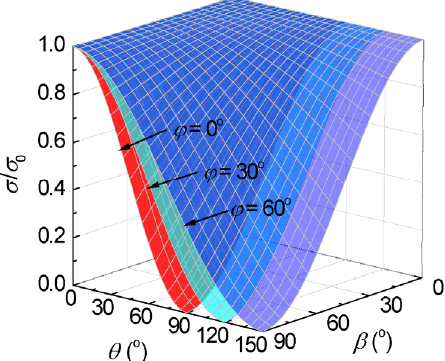
Fig. 8 Effect of the elastic recovery on the contact normal stress (  is the included angle;  is the attack angle).